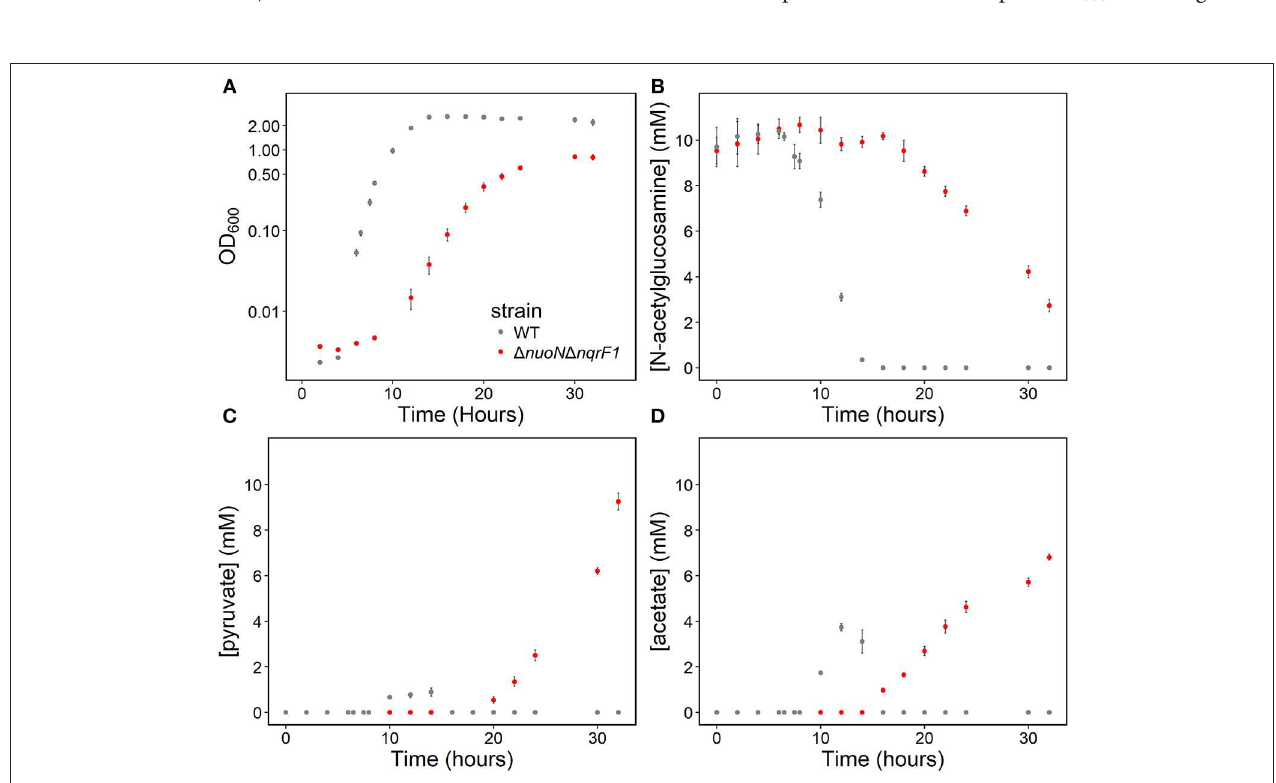
FIGURE 4 | (A) Growth of WT (gray) and 1 nuoN 1 nqrF1 (red) in 50-mL culture volumes of M5 minimal medium supplemented with 0.1% tryptone and 10mM N-acetylglucosamine (NAG). (B) NAG utilization by WT and 1 nuoN 1 nqrF1 . (C) Pyruvate and (D) acetate concentrations in culture supernatants.